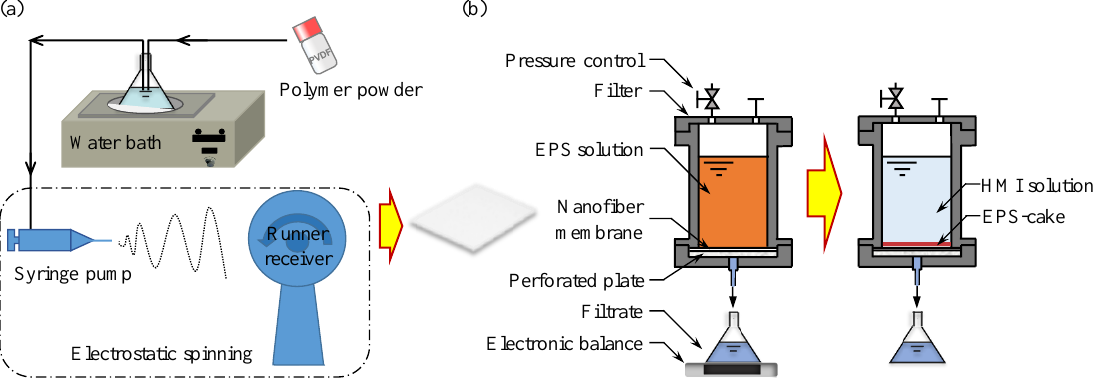
Figure 1. Schematic representations of ( a ) the nanofiber membrane fabrication process, and ( b ) the dead-end filtration apparatus and the experimental process employed herein.